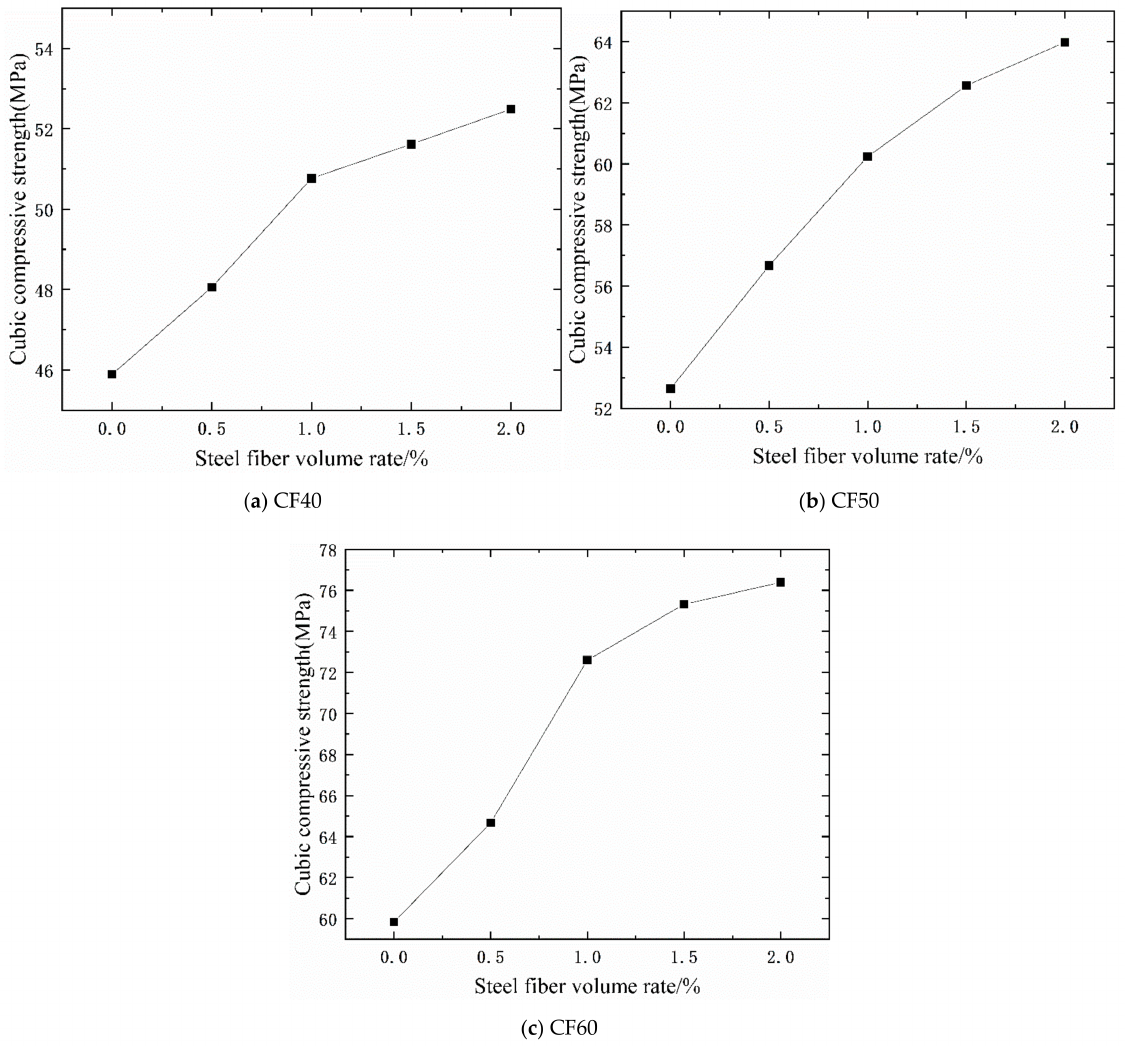
Figure 5. The relationship between cubic compressive strength and steel fiber content. CF40 ( a ), CF50 ( b ), and CF60 ( c ).